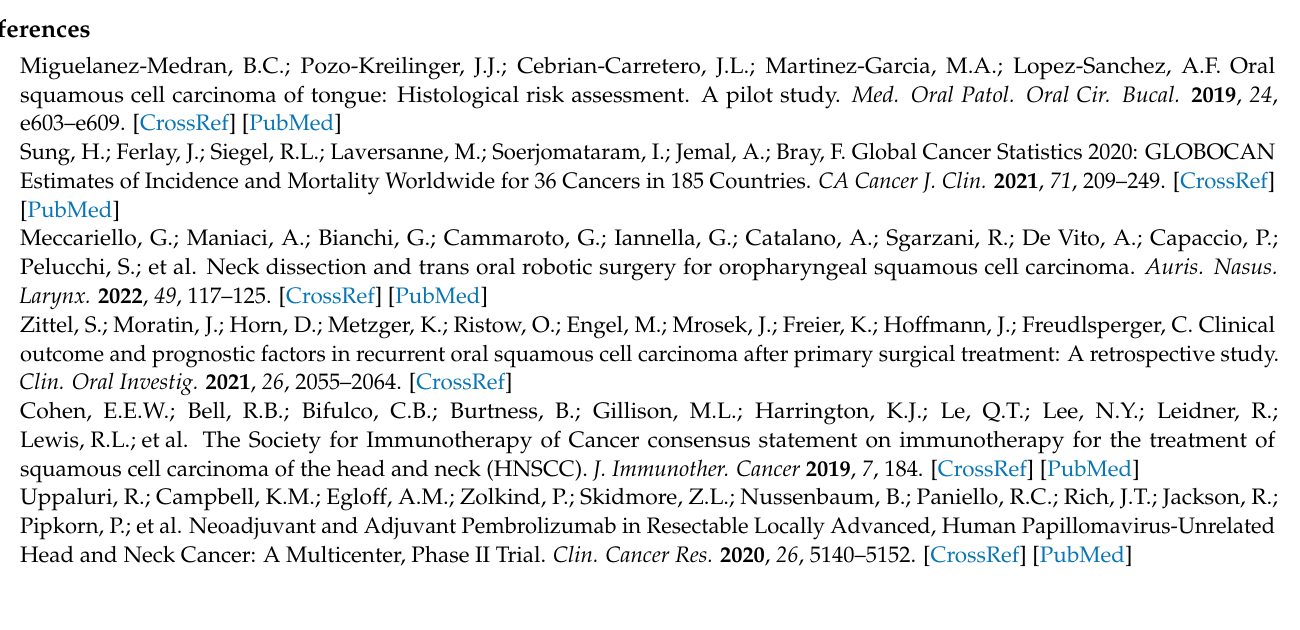
Table S3: Correlation of CD115, CD163 and CD68. (A) All samples were used. (B) OSCC group. (C) NOM group. p value is calculated by Spearman’s rho correlation. * The correlation is signifi- cant at the 0.01 level (2-tailed). ρ = Correlation Coefficient. n = number of observations correlated; Figure S1: Moderate positive correlation between PD-L1 and PD-L2 expression; Figure S2: Corre- lation between the inhibitory ligand CD155 and its receptors CD96 and TIGT. Positive correlation between CD155 and CD96 expression could be shown. No correlation of CD155 expression and TIGIT could be proven. A positive correlation between CD96 and TIGIT expression could be determined; Figure S3: Positive significant correlations between CD115 expression and CD68 and CD163 ( n = 139). Expression of CD68 and CD163 was correlated strongly; Figure S4: Expression of CD137 and of its ligand CD137L was strongly